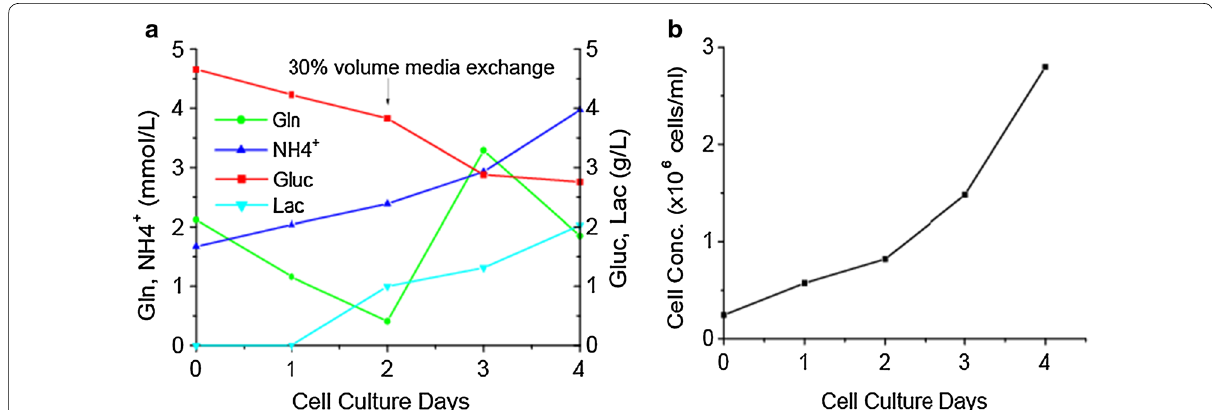
Fig. 5 Vero cell growth in WAVE25 bioreactor. a Metabolite analysis of Vero cell growth in WAVE25 (on day 2, 30% CV media exchanged, and additional 20 mM glutamine was supplied in the bioreactor). b Vero cell growth curve in